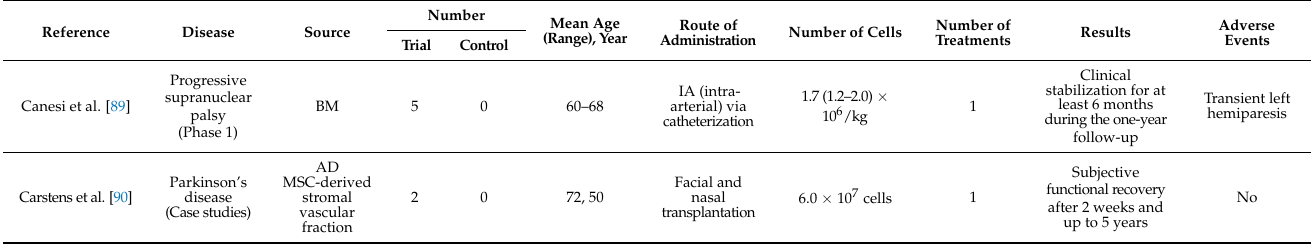
Table 6. Summary of recent clinical trials using MSCs for Parkinson’s disease.